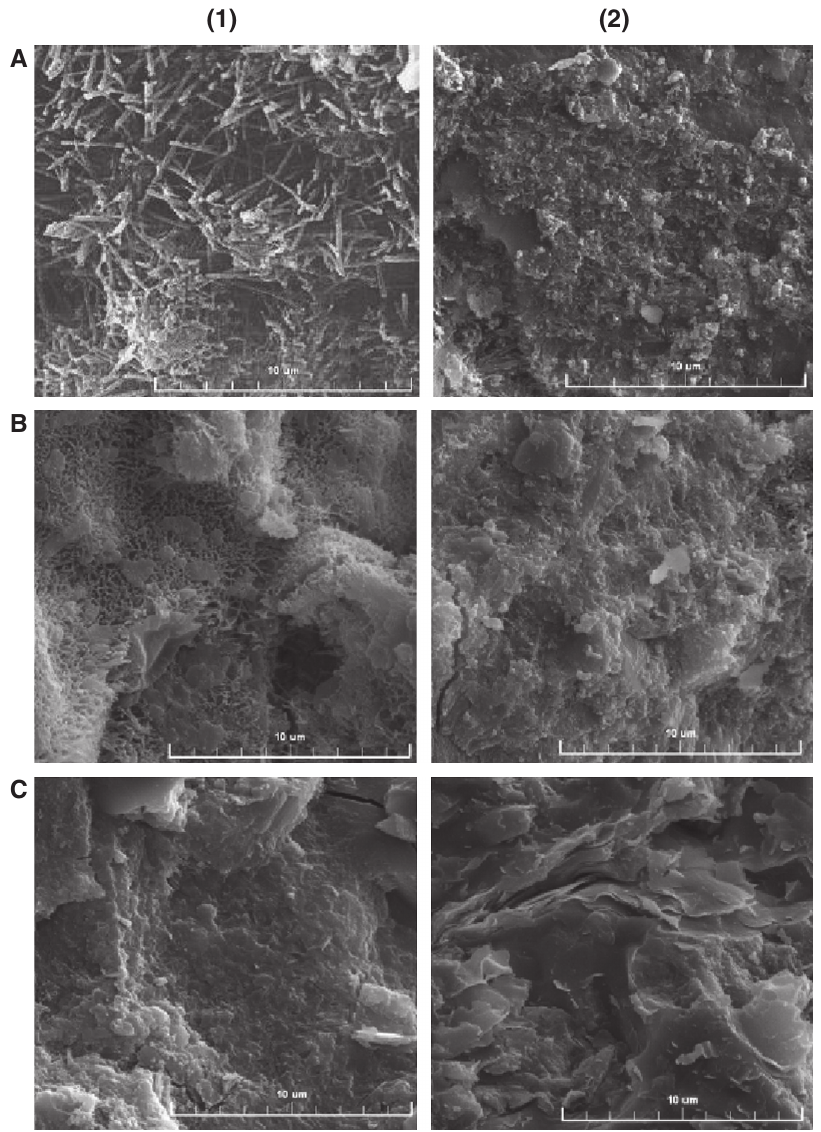
Figure 5 SEM micrographs of SCC-N mixtures: (A) without nanoparticles, (B) with 1 wt% nanoparticles, and (C) with 4 wt% nanoparticles at 7 days (series 1) and 90 days (series